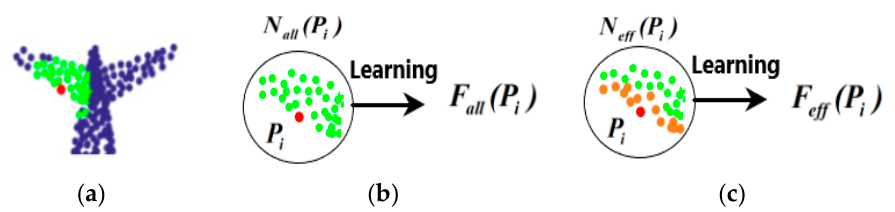
Figure 4. The diagram of the neighborhood learning. ( a ) Aircraft tail. ( b ) Feature learning on the k -NN neighborhood of the point P i . ( c ) Feature learning on the effective neighborhood (the orange points) which is more appropriate for feature learning of the edge of the wing.